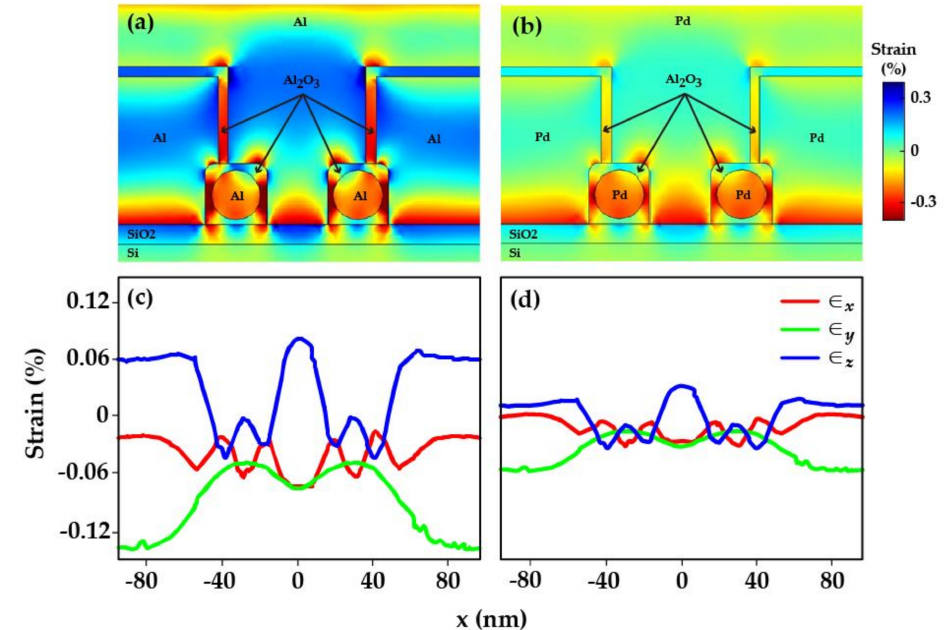
Figure 3. Simulated strain for Al and Pd gates on Si-bulk based on Figure 1b model at the SiO 2 thickness of 10 nm. ( a , b ) are the cross-section strain ∈ z cut at xz axis plane, while ( c , d ) are the strain components ∈ ∈ ∈ x , y and z at 1 nm below the Si–SiO 2 interface for Al gates and Pd gates, showing the e from CTE mismatch of Al–Al 2 O 3 and Pd–Al 2 O 3 , respectively.